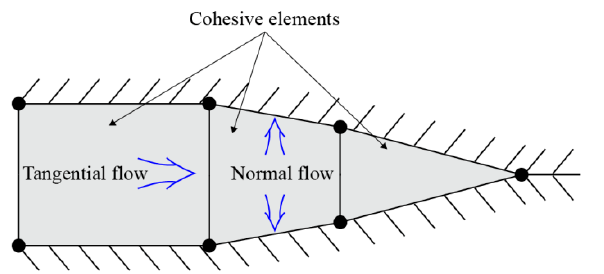
Figure 2. Schematic diagram of fluid flow in a fracture. The crack is presented using a cohesive cracking model, where fluid flows within a cohesive element.